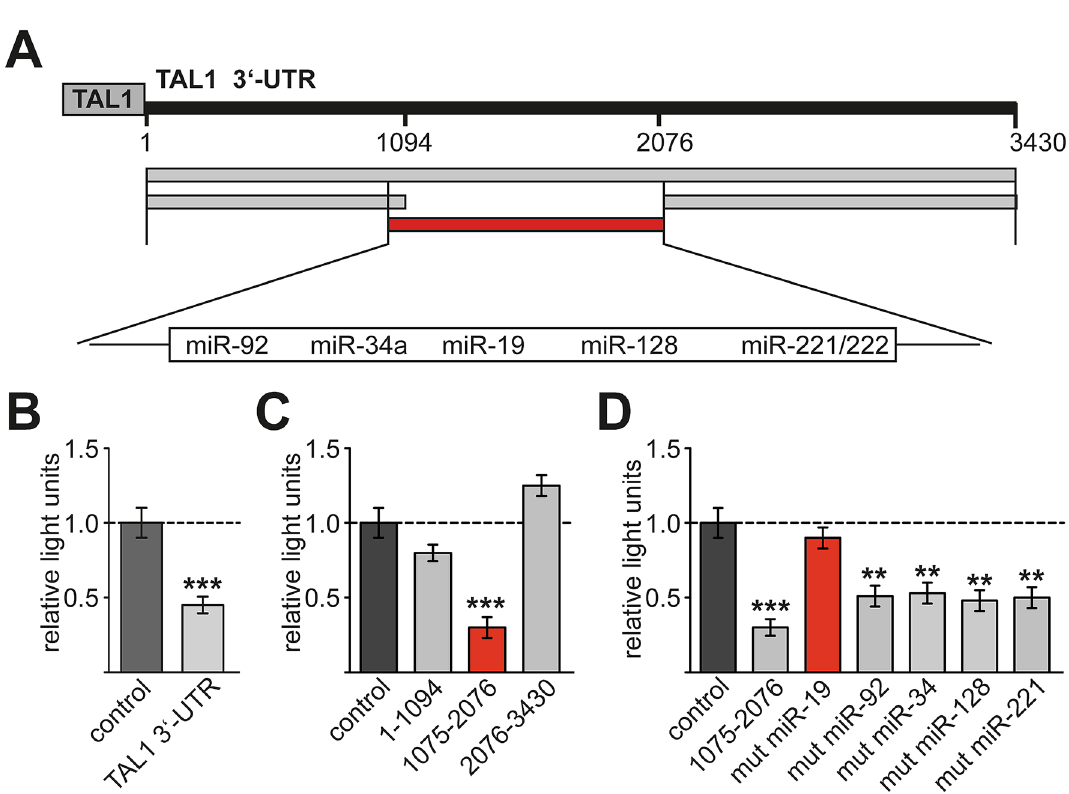
Figure 1. SILAC based mass spectrometry reveals miR-17-92 targets. ( A ) Jurkat cells were transduced with miR-17-92 and the corresponding empty vector control LegoiG2. The control cells were cultured for five passages in light SILAC medium, containing normal amino acids. miR-17-92 overexpressing cells were cultured in heavy SILAC medium labelled with heavy isotopes. Nuclear extracts were prepared and light and heavy SILAC labelled cells were mixed in a one to one ratio and applied to LC–MS/MS analysis. ( B ) 4896 proteins were analysed, thereof 324 proteins were downregulated by an H/L ratio of at least 0.7. ( C ) GO-term analysis of downregulated proteins using DAVID. ( D ) MS-spectrum of a TAL1 peptide shows downregulation of TAL1 protein in the miR-17-92 sample. ( E ) Protein interaction network analysis of the 324 downregulated proteins using STRING revealed that the TAL1 interactors HEB, E47 and LDB1 are among the downregulated proteins. ( F ) The members of the TAL1 interaction network E47, HEB and LDB1 were downregulated by an H/L ratio of at least 0.7. ( G ) miR-17-92 was overexpressed in Jurkat cells under non-SILAC conditions. Protein levels of TAL1, E47, HEB and LDB1 were analysed using western blot with the corresponding antibodies. ( H ) Quantification of the protein amount of TAL1, E47, HEB and LDB1 normalized to a western blot against histone 3. The quantification from western blot in the control cells was set as one. Data are given as relative protein amount compared to the control transduced with empty vector. Western blots were performed at least three times. ( I ) mRNA expression of TAL1, E47, HEB and LDB1 was reduced upon miR-17-92 overexpression. Data are given as relative mRNA amount compared to the control transduced with empty vector. The p-values were calculated using Student’s t-test from at least three independent determinations. *P < 0.05; **P < 0.01; ***P < 0.001.